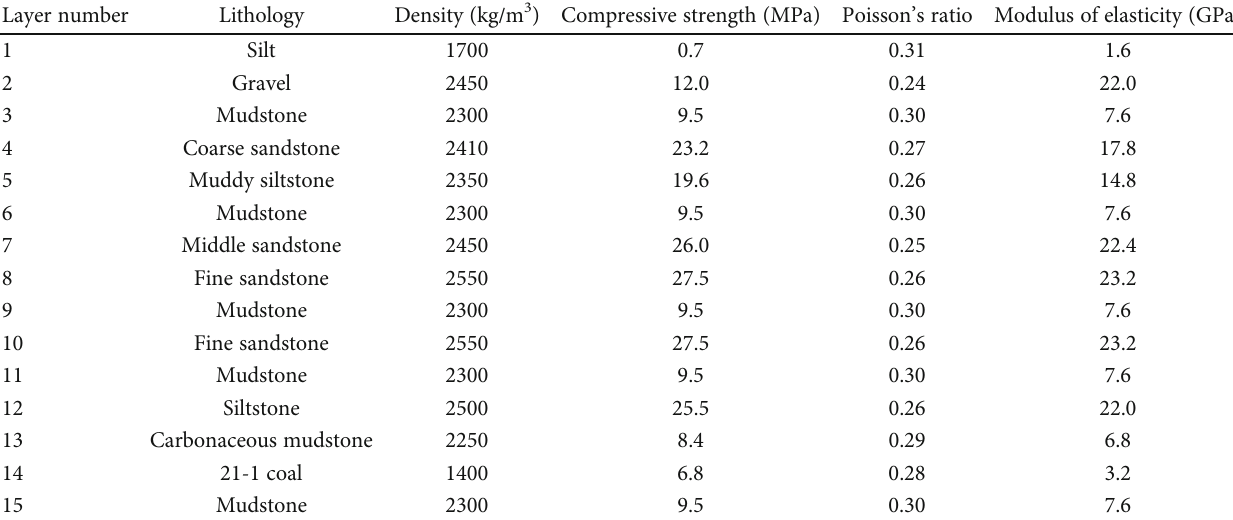
Table 1: Main physical and mechanical properties of rock